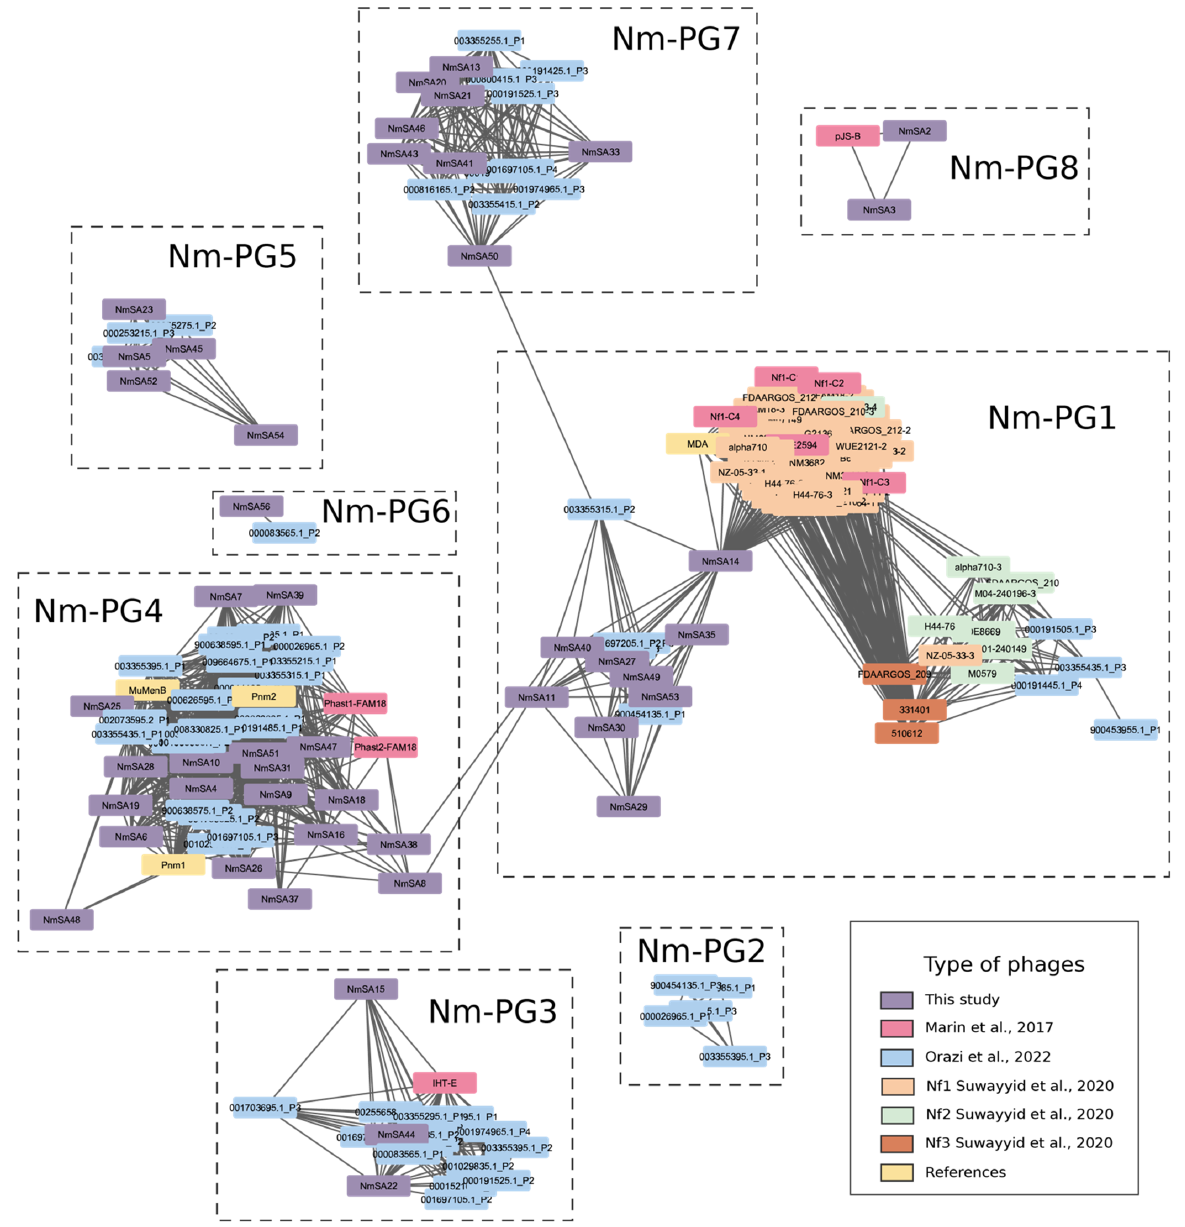
Figure 4. Comparison of the predicted prophages with prophage sequences found in the literature. The protein network was constructed using vConTACT2 [24] and visualized with Cytoscape [27]. The Nm-PG ( N. meningitidis- Prophage Group) groups of prophages were designated according to their protein content. Each prophage is labeled in color according to references of comprehensive studies. The prophages of Marin et al. (2017) [12] include strains of N. meningitidis from Brazil. The prophages predicted by Orazi et al. (2022) [25] represent a large-scale bioinformatics approach to prophage diversity in Neisseria spp . On the other hand, we also included prophages studied by Al Suwayyid et al. (2020) [28], who investigated filamentous prophages classified as MDA/Nf1, Nf2, and Nf3, according to the nomenclature proposed by Kawai et al. (2005) [10]. Finally, we included other known prophages, i.e., PS_1 reported by Bettencourt et al. (2022) [29], MDA reported by Bille et al. (2005) [11], and Mu-like prophages, such as Pnm1, Pnm2, and MuMenB reported by Masignani et al., (2001) [15]. More data related to this figure are available at GitHub (https://github.com/Leytoncito/ProphagesNM/blob/main/README.md).